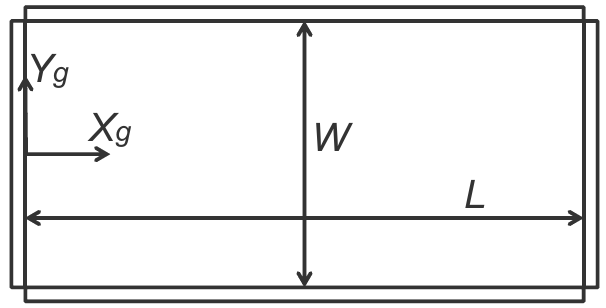
Figure 5: Boundaries of the simulation